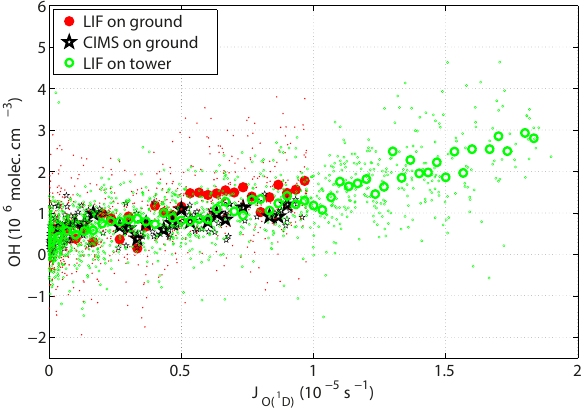
Figure 8. Linear correlation of OH and J is found during O ( 1 D ) HUMPPA-COPEC-2010. The comparison of the on-ground and above-canopy correlations shows that higher on-tower OH values are driven by enhanced radiation. Similar slopes, mainly depend- ing on the abundance of VOCs and NO x , do not suggest differences in the chemical regime. Small symbols show 5min data set, large symbols are mean of data binned in steps of 3 × 10 − 6 s − 1